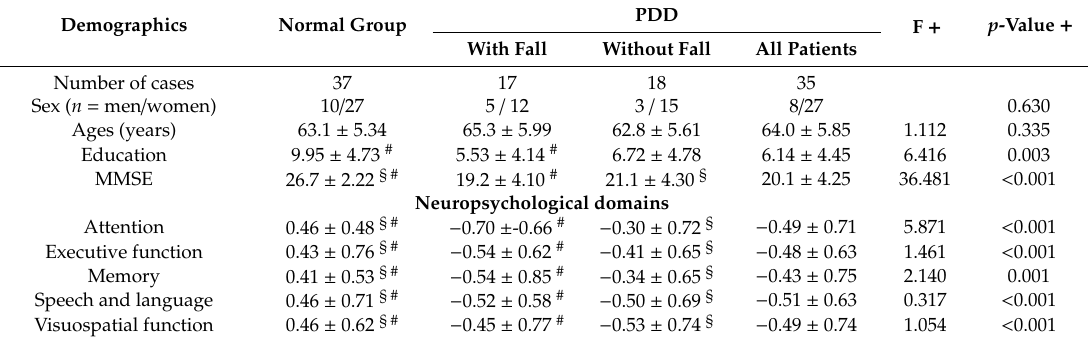
Table 1. Demographic characteristics of PDD patients and normal